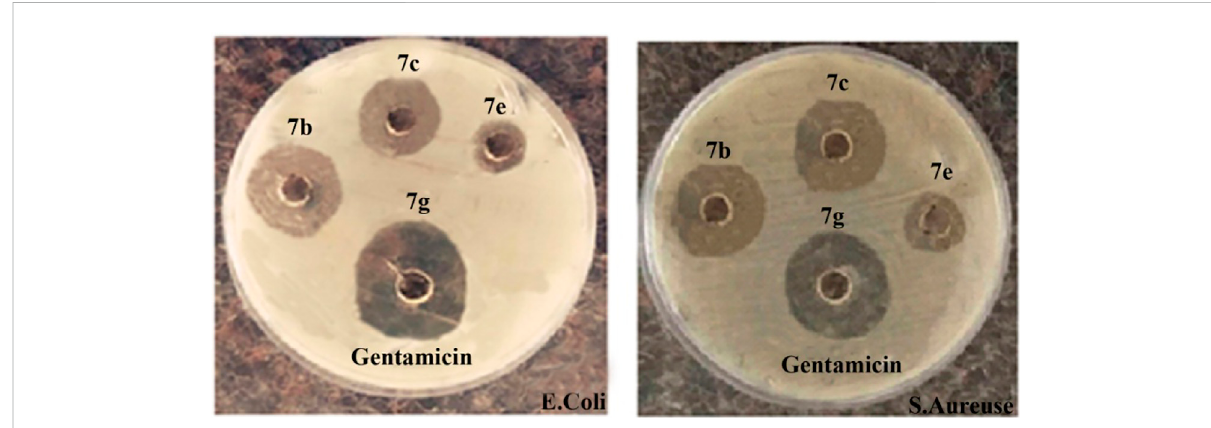
FIGURE 8 Comparison between the activity of the synthesized compounds with gentamicin.